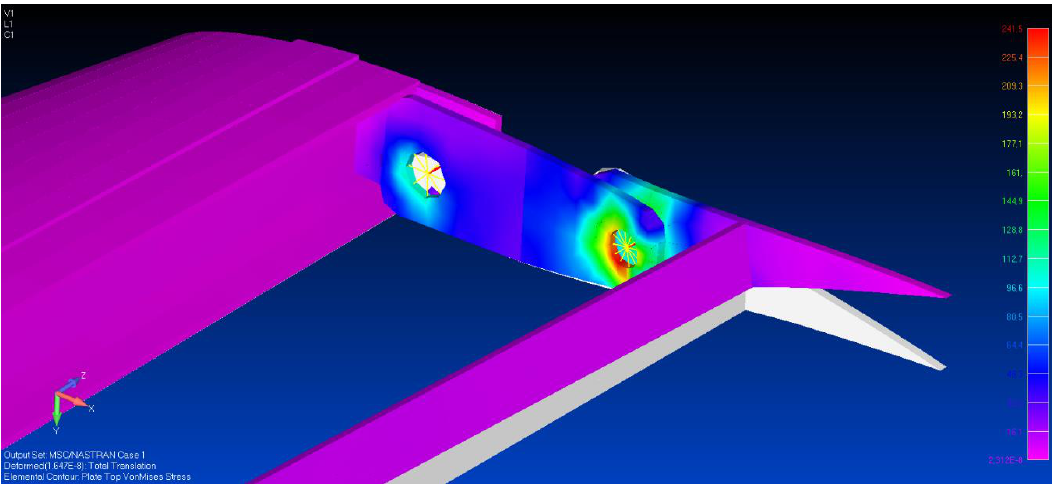
Figure 14. Stress distribution (MPa) over the finger-like mechanism under aerodynamic loads.